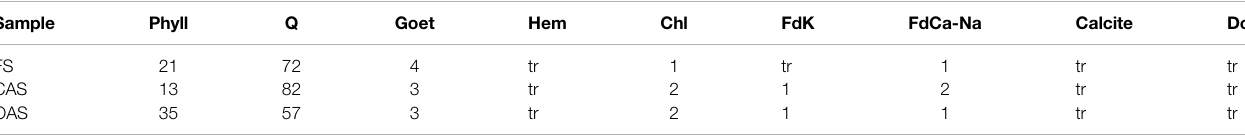
TABLE 2 | Mineralogical composition of the fi ne-earth fraction ( < 2 mm; DRX-disoriented powder, %). Sample